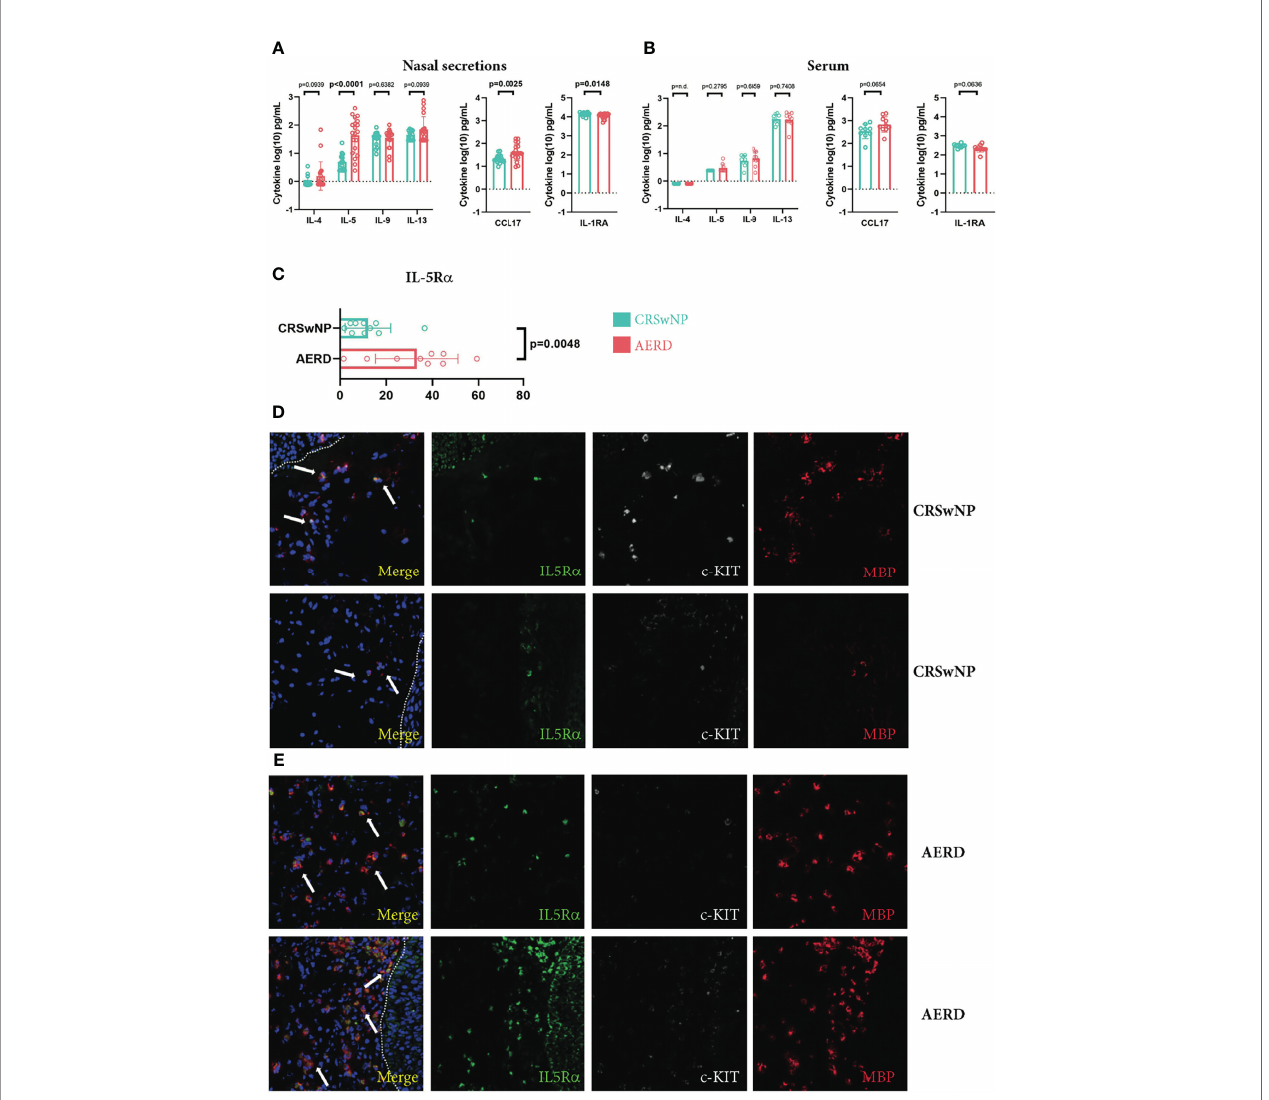
FIGURE 1 | Increased IL-5 and IL-5R a levels in patients suffering from AERD. (A, B) IL-4, IL-5, IL-9, IL-13, CCL17 and IL-1RA levels (y-axes, pg/ml) in (A) nasal secretions or (B) serum of patients suffering from CRSwNP (blue, n = 9) or AERD (red, n = 10) measured by MSD platform. (C) Quanti fi cation of the percentage of IL-5R a cells of total cells (x-axes) in nasal polyp tissues of patients suffering from CRSwNP (blue, n = 9) or AERD (red, n = 10). (D, E) Representative immuno fl uorescence staining of IL-5R a -positive cells (green, white arrows at merge) in polyp biopsies of (D) CRSwNP or (E) AERD patients. Tissues were co-stained with c-KIT (white) and MBP (red). Dotted lines indicate epithelium. Cytokine concentrations were log-transformed for analysis. Signi fi cance levels are indicated in fi gures, bars, and error bars represent means with SDs. AERD, aspirin-exacerbated respiratory disease; CRSwNP, chronic rhinosinusitis with nasal polyps; MBP, major basic protein; MSD, mesoscale